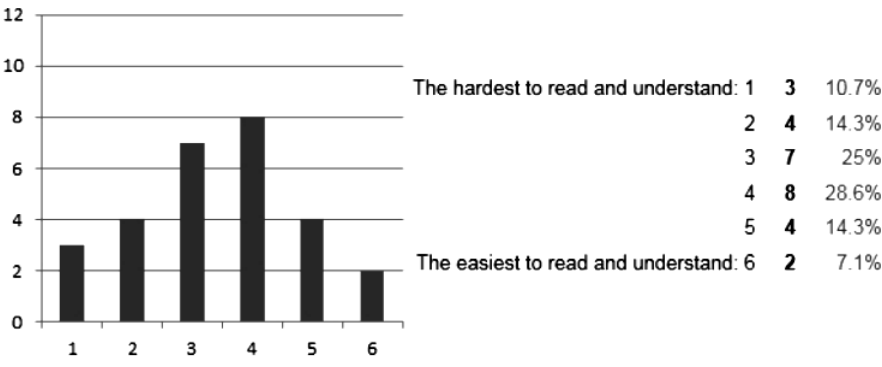
Figure 5. Distribution of marks – UML-like languages